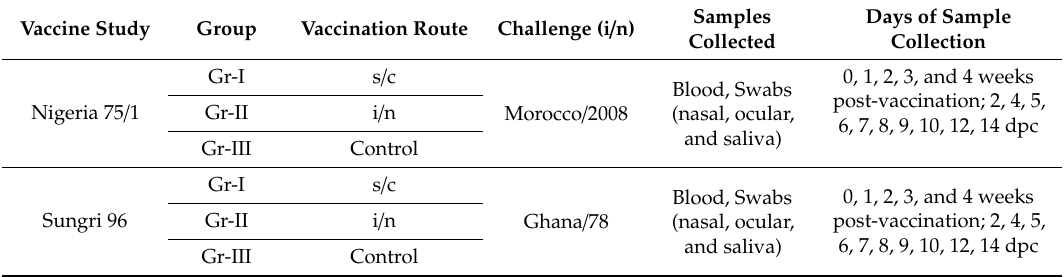
Table 1. Design of the animal experiment. s / c: subcutaneous; i / n: intranasal; dpc: days